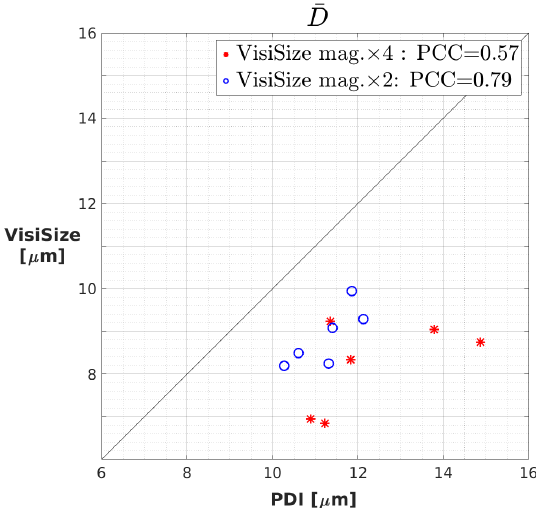
Figure A1. Comparison of the arithmetic mean droplet diameters between the VisiSize and the PDI probe channel 1. The blue circle represents measurement cases where the VisiSize lens magnifica- tion of × 2 was used, while the red star shows the measurements with × 4 magnification. Each measurement case is between ∼ 7– 14min, while both instruments were collecting cloud droplet data simultaneously. The PCC is also shown in the